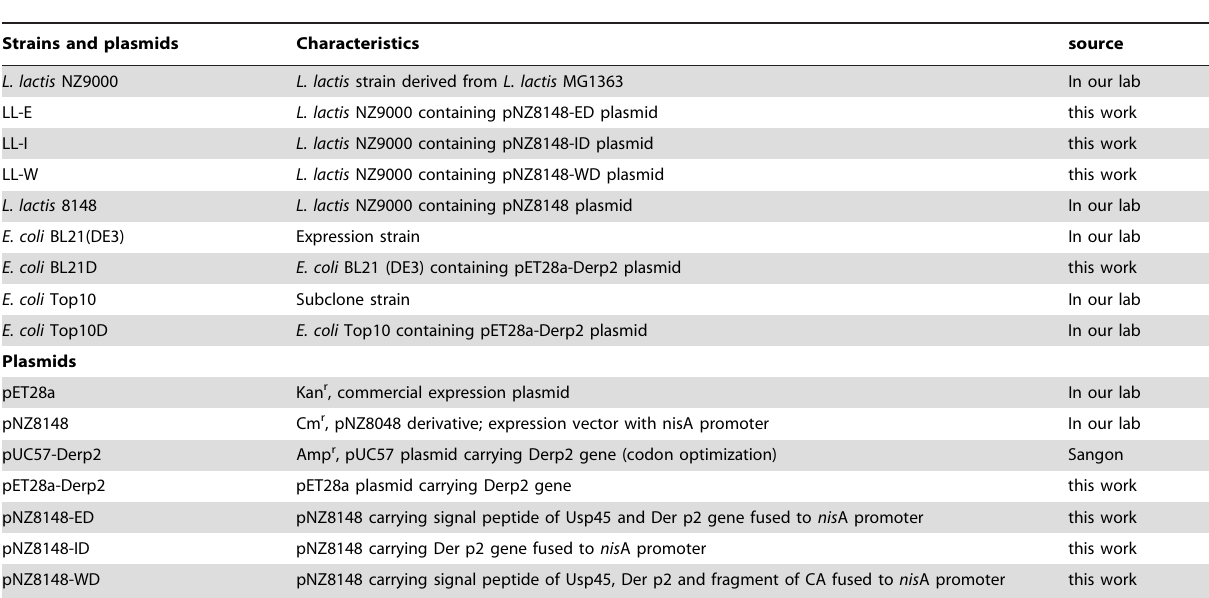
Table 1. Bacterial strains and plasmids used in this study.